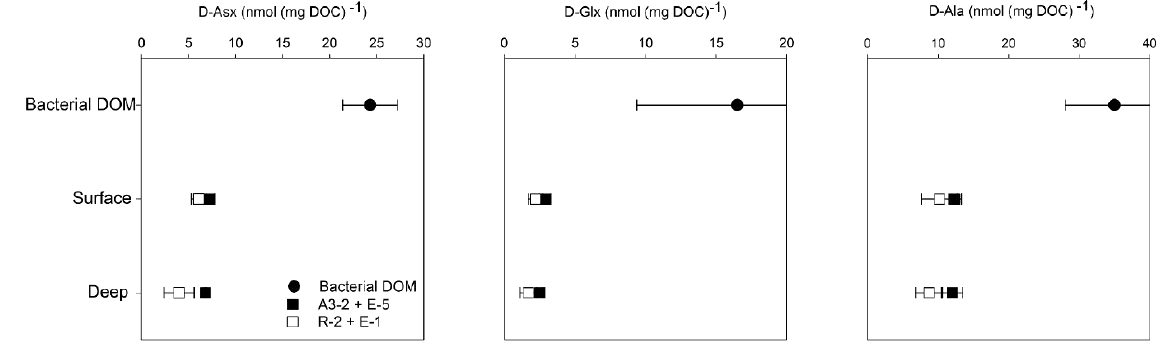
Figure 6. Average C-normalized yields of D-aspartic acid or D-asparagine (D-Asx), D-glutamic acid or D-glutamine (D-Glx), and D-alanine (D-Ala) in bacterial DOM (Kaiser and Benner 2008) and DOM from surface (0–120m) and deep waters ( > 120m) at stations impacted (A3-2 + E-5) or not (R-2 + E-1) by the bloom. Error bars represent standard